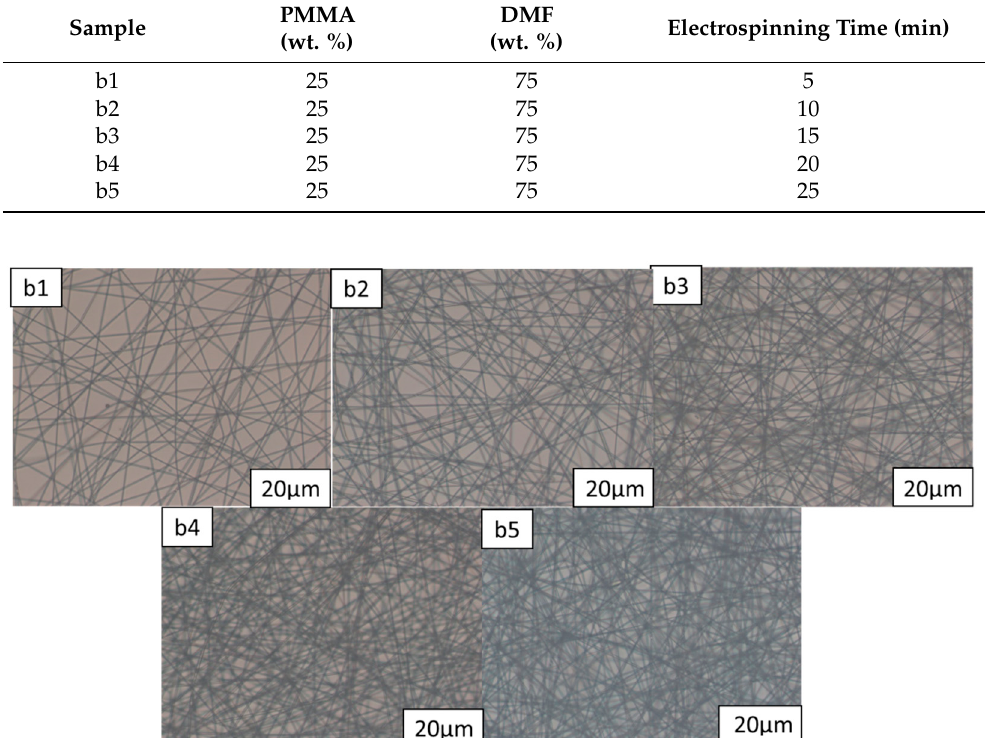
Figure 4. Microscopic morphology of nano fi bers of ( b1 – b5 ).